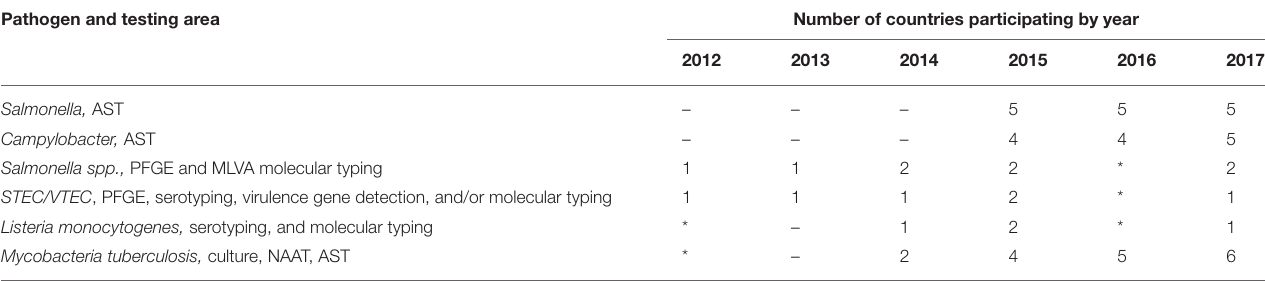
TABLE 1 | Western Balkan countries participation in ECDC-supported laboratory external quality assessment schemes offered to EU pre-accession countries, by target pathogen, testing area, and